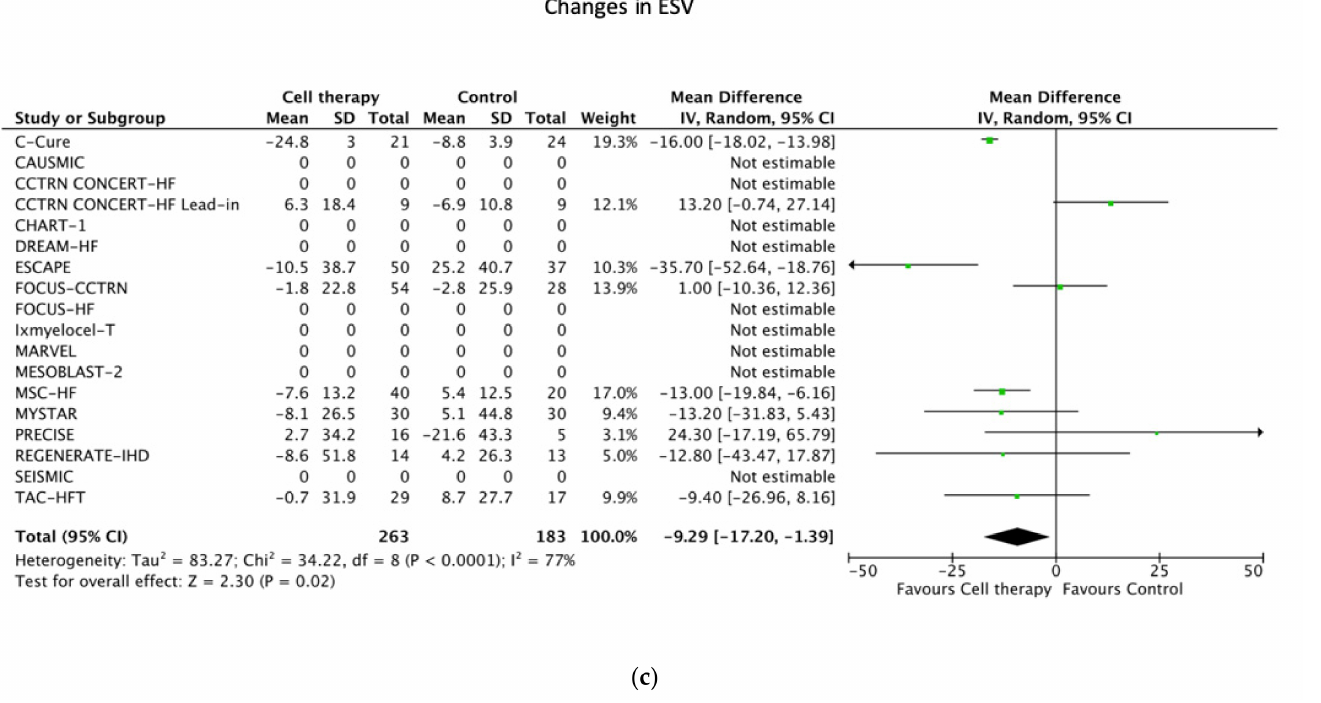
Figure 3. ( a ) Primary efficacy endpoint: changes in EF in patients randomized to receive percutaneous endocardial delivery of regenerative cells or controls. ( b ) Secondary efficacy endpoint: changes in EDV in patients randomized to receive percutaneous endocardial delivery of regenerative cells or controls. ( c ) Secondary efficacy endpoint: changes in ESV in patients randomized to receive percutaneous endocardial delivery of regenerative cells or